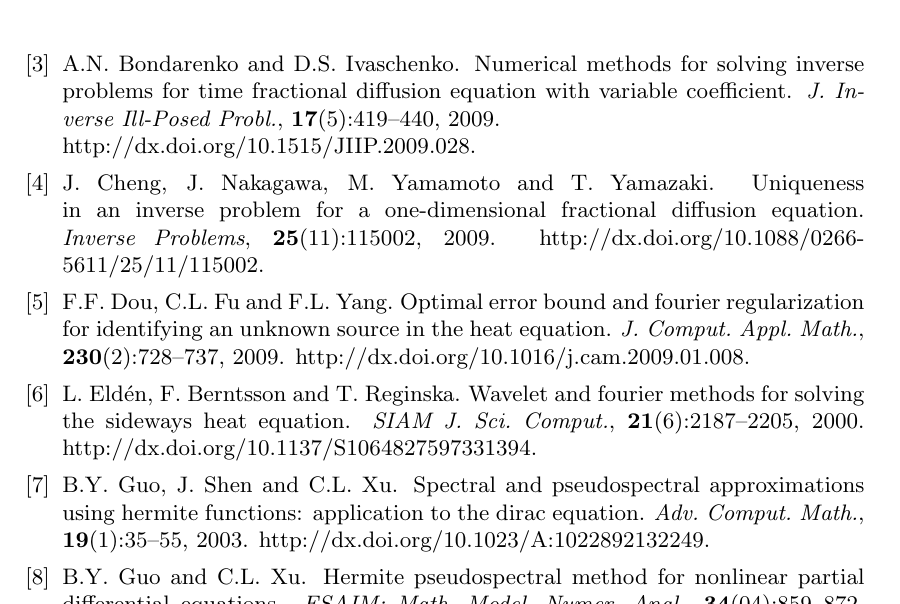
Figure 6. The variation of E f with δ 1 (Example